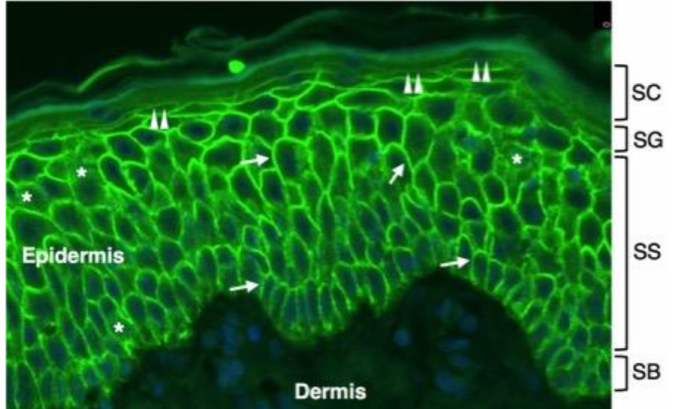
Figure 2. Immunofluorescence distribution of AQP3 in normal human epidermis. Shown is im- munofluorescence analysis of AQP3 labelling in the epidermis of a normal human subject. Skin tissue was formalin-fixed and paraffin-embedded. Sections were stained using an anti-human AQP3 antibody recognizing AQP3 (Thermo Fisher Scientific, Monza, Italy). Cell nuclei were stained with DAPI (blue fluorescence). Strong AQP3 immunoreactivity (green fluorescence) is seen over the plasma membrane of stratum basale (SB) and stratum spinosum (SS) keratinocytes (arrows). Weak intracellular immunoreactivity is observed in the intracellular compartment (asterisks). The plasma membrane immunostaining of SG keratinocytes is lower than the one of the underlying epidermal layers (double arrowheads). No immunofluorescence is seen in the stratum corneum (SC) of the epidermis and in the